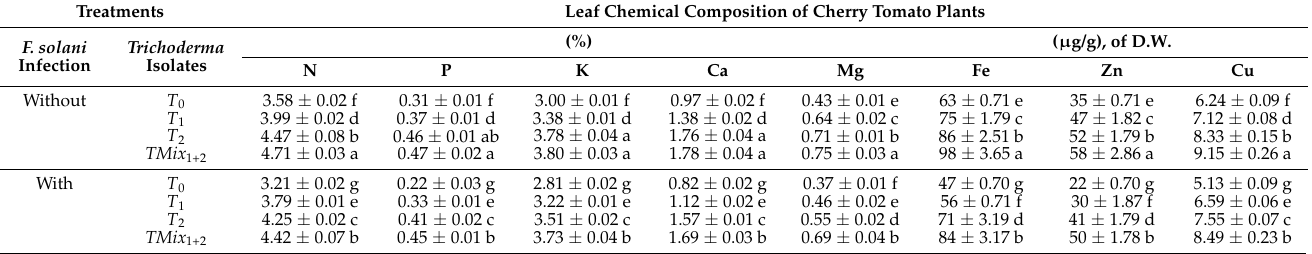
Table 3. Leaf chemical composition (%) of cherry tomato plants grown under greenhouse conditions with and/or without F. solani infested soil, as affected by different Trichoderma treatments. Leaf Chemical Composition of Cherry Tomato